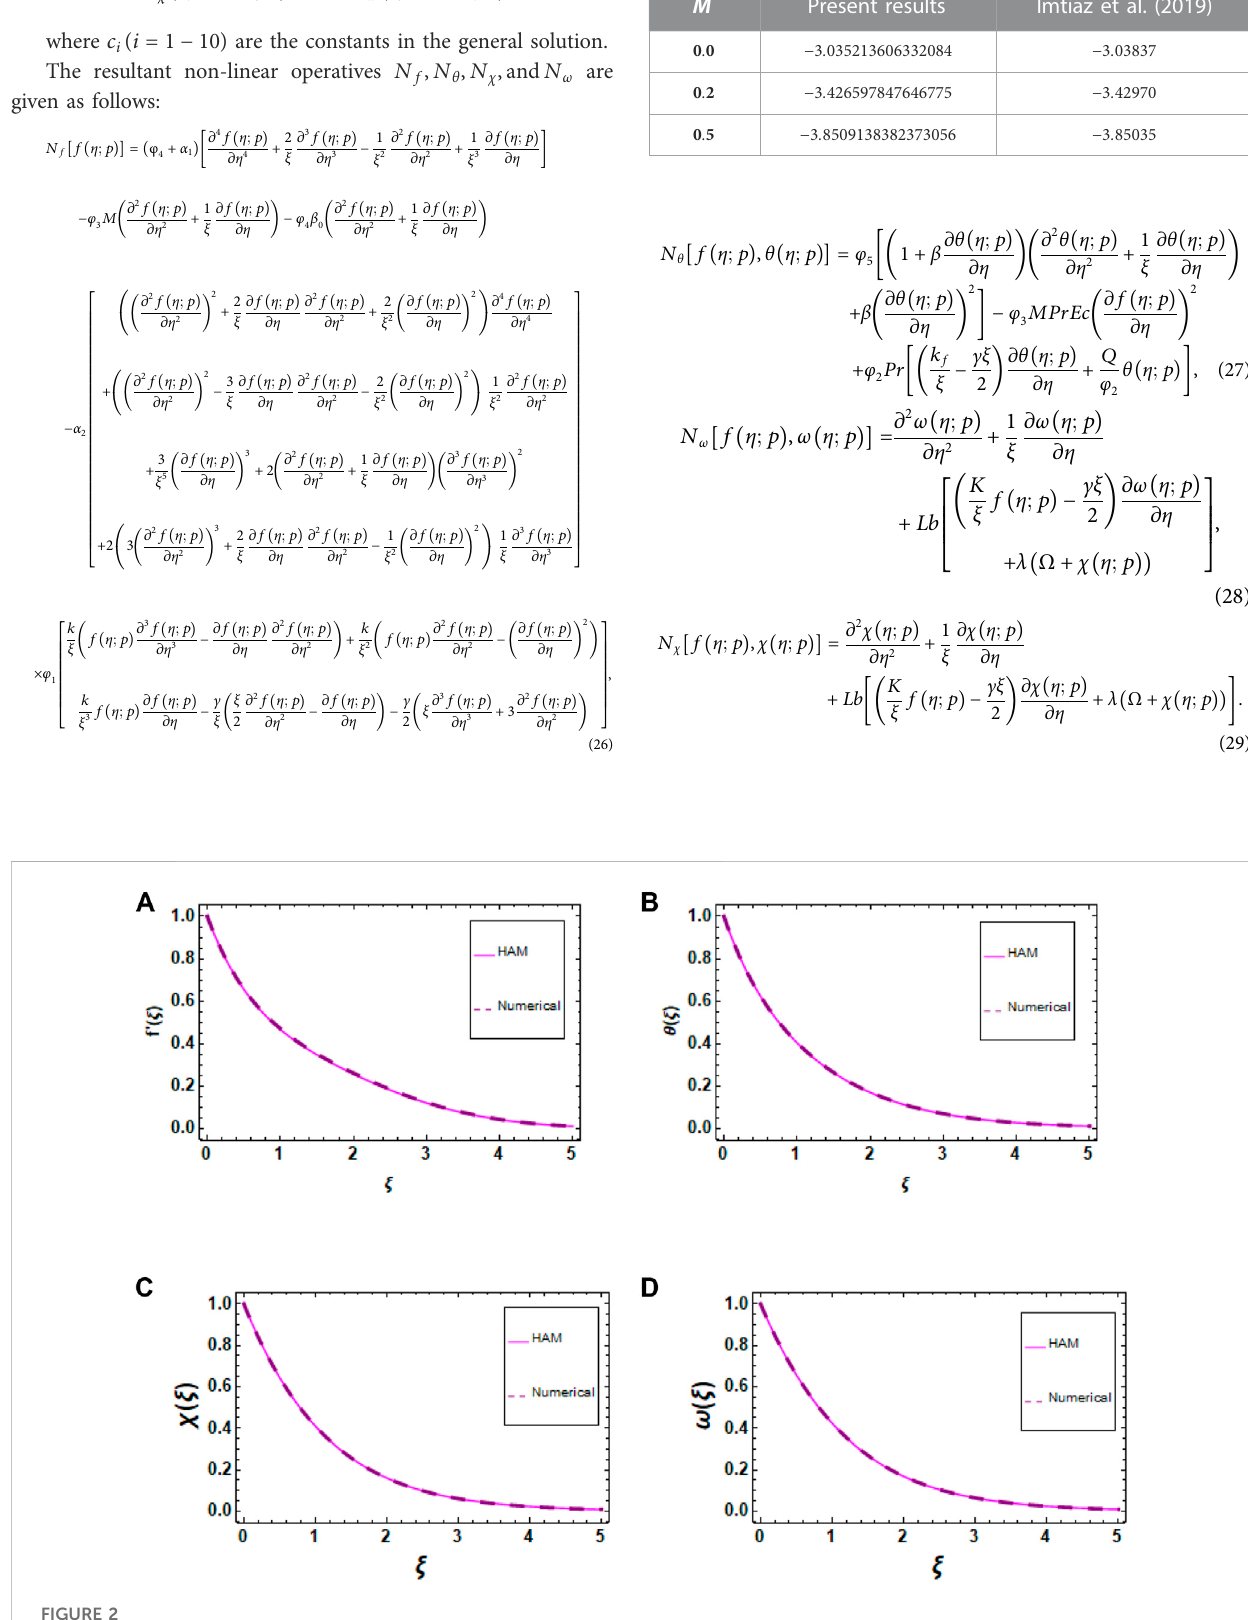
FIGURE 2 (A – D) Graphical validations of the HAM with numerical methods for f ′ ( ξ ) , p ( ξ ) , θ ( ξ ) , and χ ( ξ )